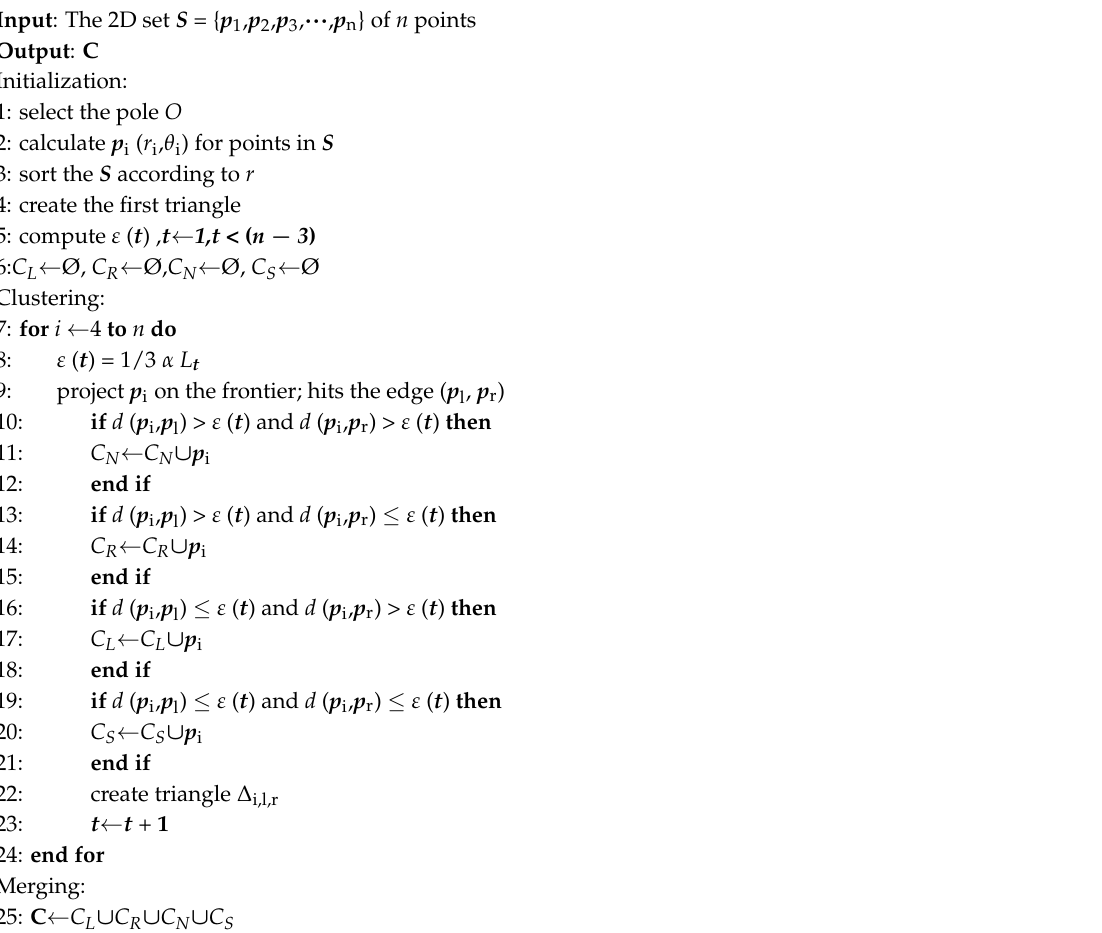
Algorithm 1 . ASC clustering